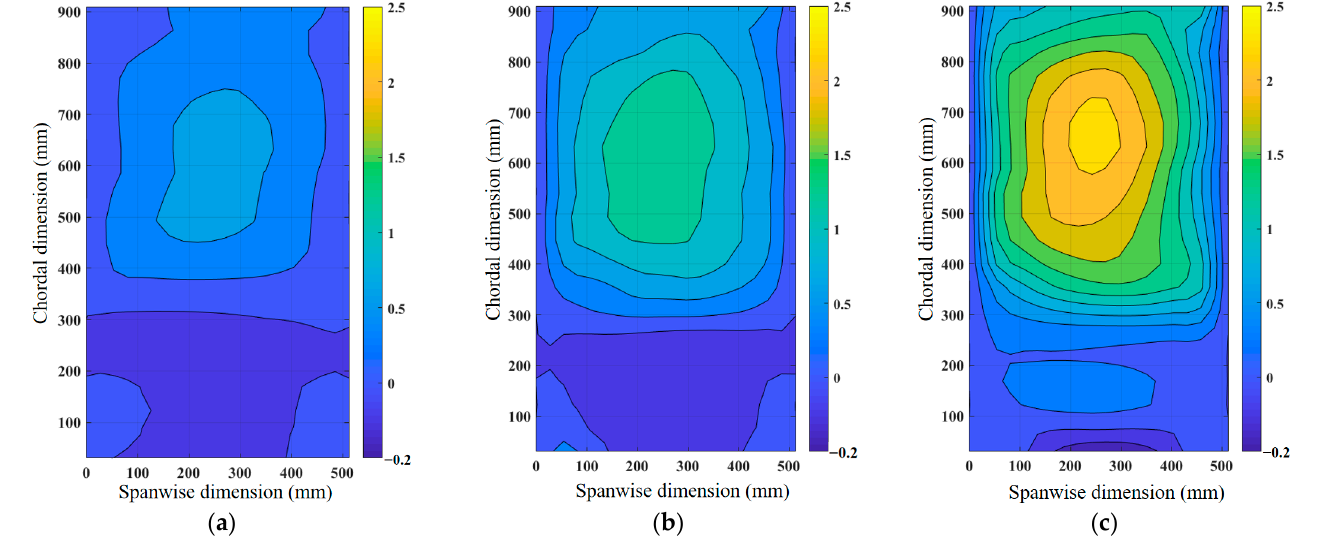
Figure 10. Deformation of the upper surface ( α = 4°): ( a ) v = 6.4 m/s; ( b ) v = 9.0 m/s; ( c ) v = 11.0 m/s.